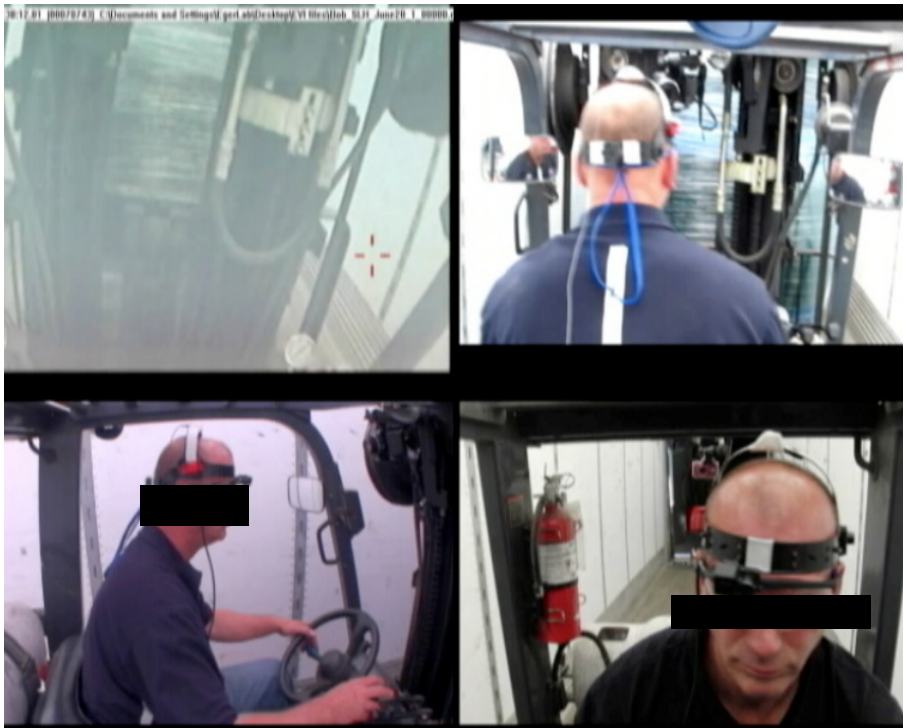
Figure 2. Sample images from the composite video showing the time-matched video data from the eye gaze camera and the views of the operator. The top left view shows the image from the eye gaze camera. The red cursor in the bottom-right of this image identifies the operator’s point of regard at this particular instant; the top right view shows the image from the rear video camera at the back—in this case it shows a similar perspective as the eye gaze camera; the bottom left view shows the image from the video camera at the side of the cabin; the bottom right view is from the video camera at the front of the